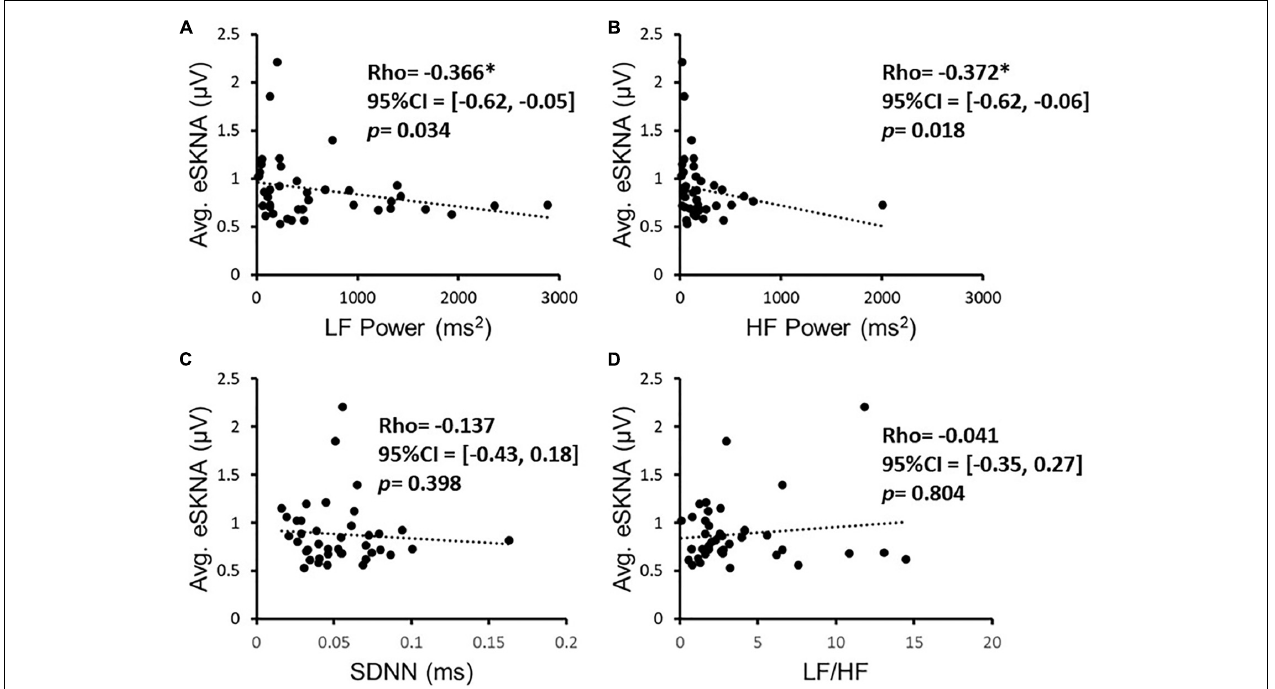
FIGURE 3 | The correlation of eSKNA and the parameters in HRV analysis in 40 study subjects. (A,B) Show the significant correlations between eSKNA and LF power, and eSKNA and HF power, respectively. (C,D) Show no correlation between eSKNA and SDNN, and eSKNA and LF/HF, respectively. *Statistically significant ( p <